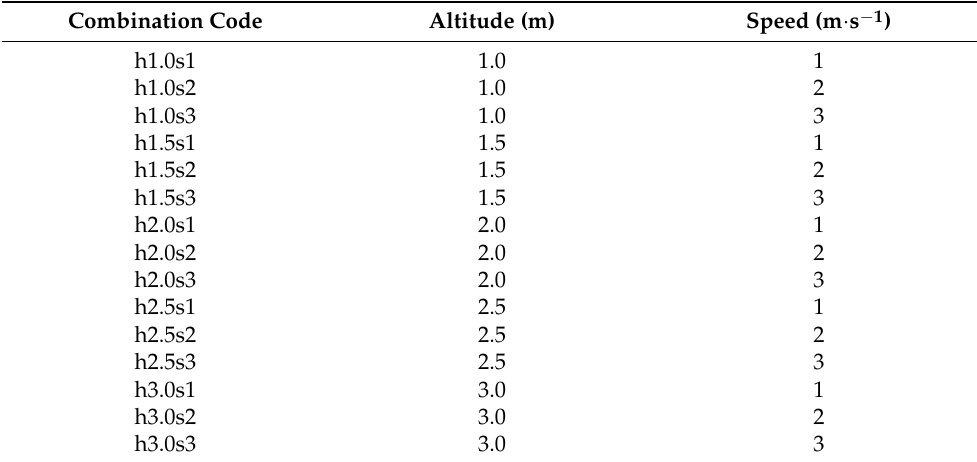
Table 2. Combination of flight parameters.